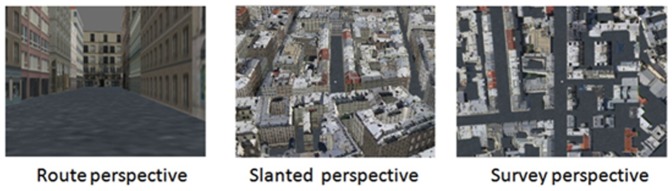
Examples of route, slanted, and survey perspective views.